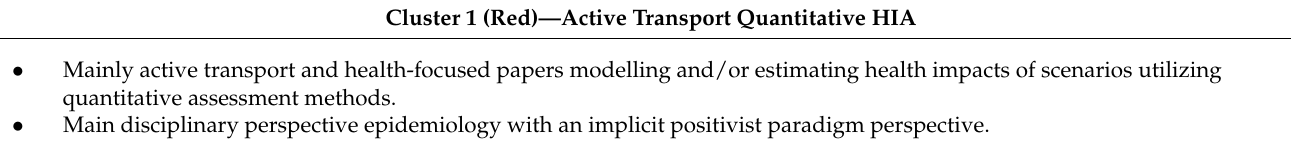
Table 2. Top five publications with the highest total link strength in each document co-citation